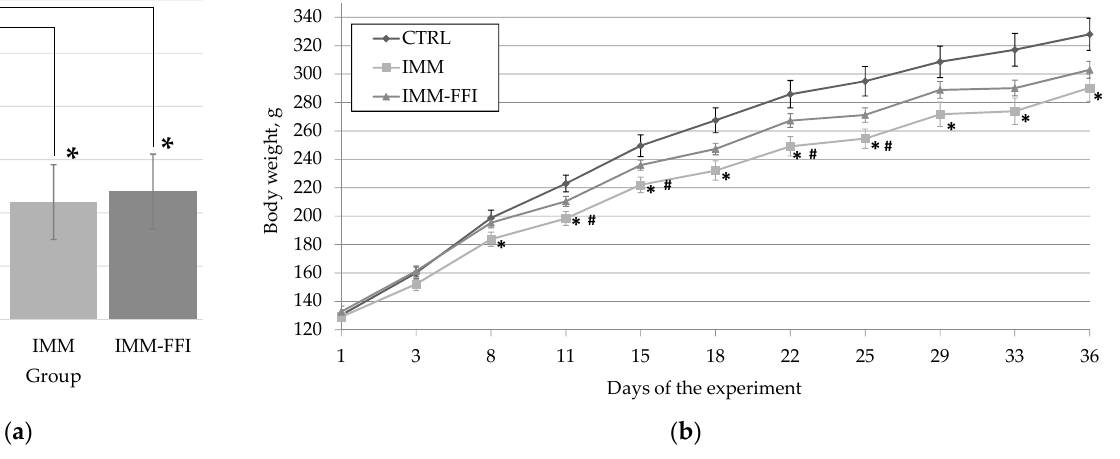
Figure 1. Integral indicators of rats during experiment No. 1: ( a ) average animal feed intake, g/day/rat; ( b ) average rats weight gain, g. *—differences are significant compared with the CTRL group, p < 0.05. # —differences are significant compared with the IMM-FFI group, p < 0.05.